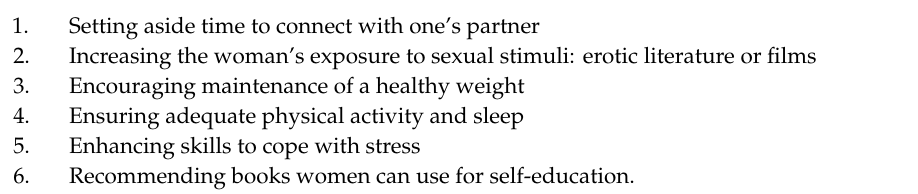
Table 4. General lifestyle